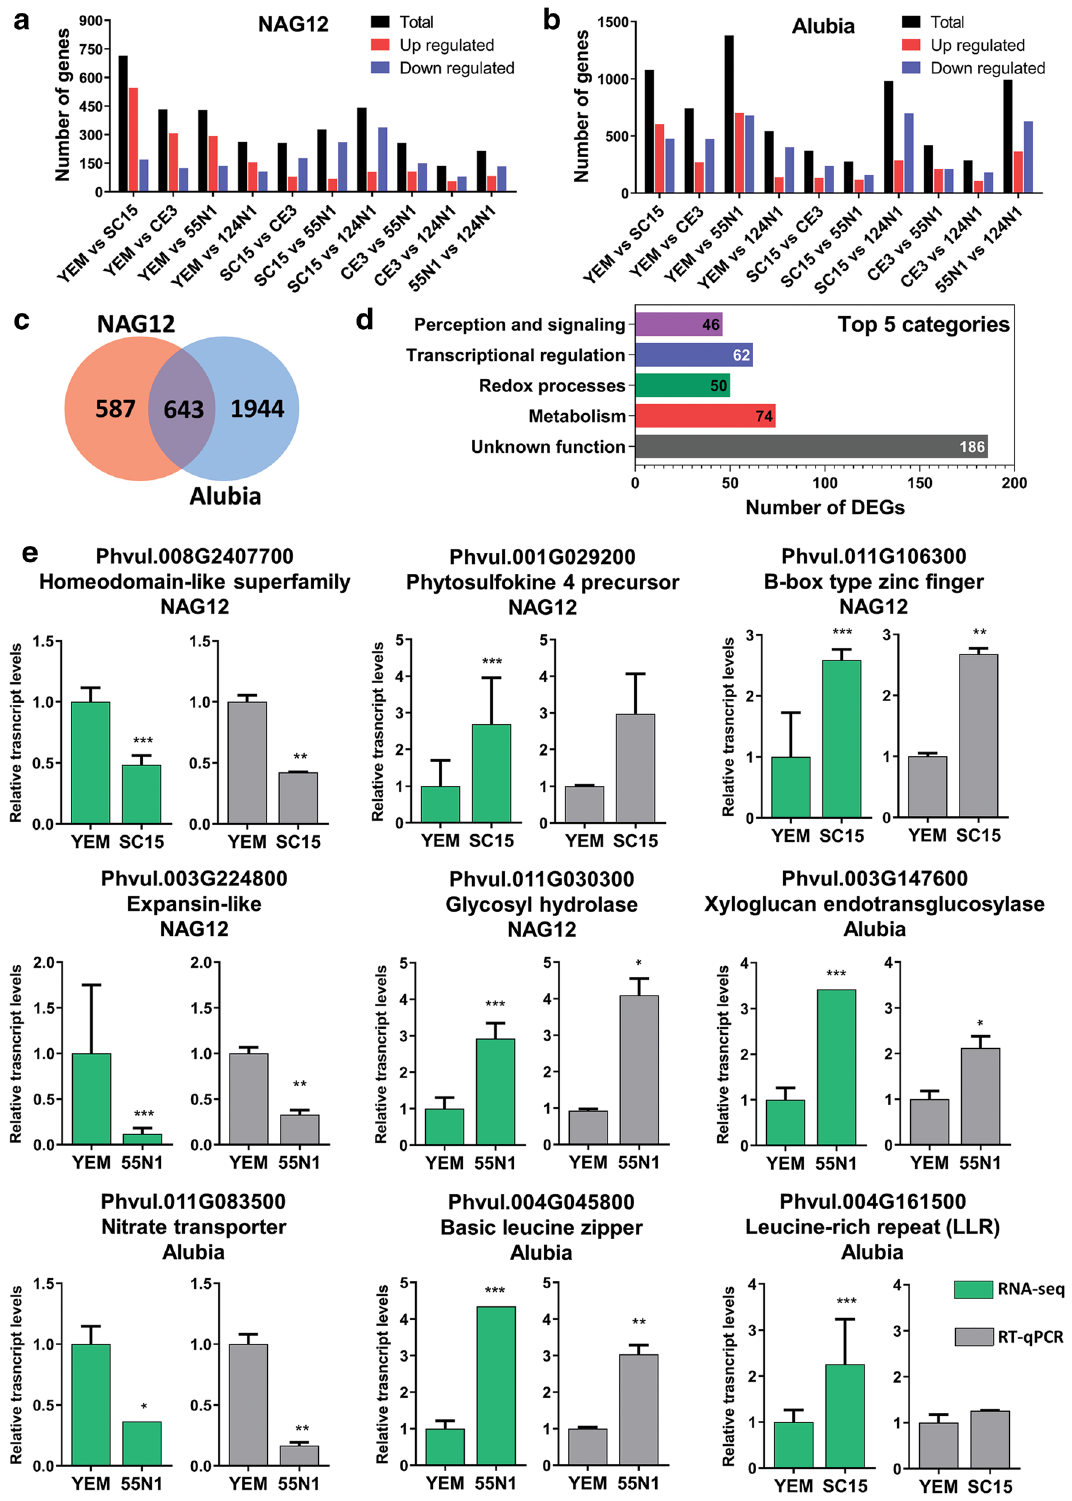
Figure 2. Differentially expressed genes (DEG) detected by RNA-seq and RT-qPCR validation. ( a,b ) Number of total (black bars), up-regulated (red bars) or down-regulated (blue bars) DEGs in each pairwise comparison in NAG12 ( a ) and Alubia ( b ) accessions. ( c ) Venn diagram showing the total number of DEGs in each accession and the number of DEGs common to both accessions. ( d ) Top five functional categories of the DEGs common to NAG12 and Alubia. ( e ) Validation of RNA-seq data by RT-qPCR. The expression of selected DEGs quantified by RNA-seq (green bars) and qRT-PCR (gray bars) is shown. In both cases, expression data is presented as relative to the expression value in the sample treated with YEM, which was set at 1. Bars represent the mean and whiskers the SD. Asterisks indicate significant differences in an unpaired two-tailed Student’s t-test (* p < 0.05; ** p < 0.01; *** p <